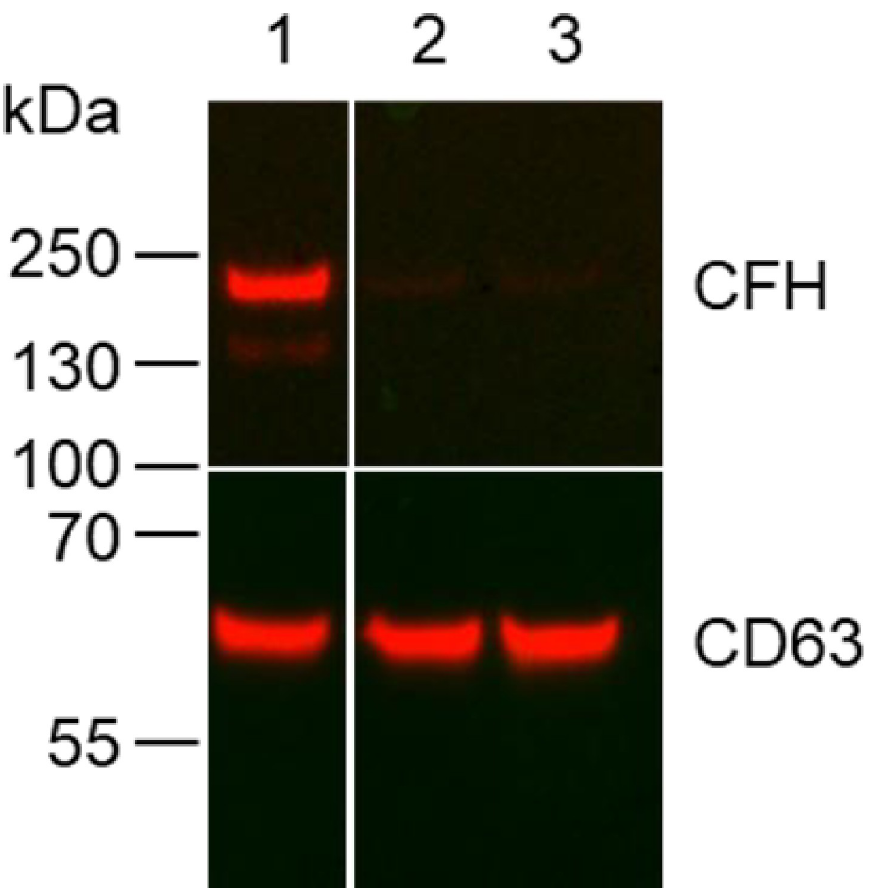
Fig 1. CFH in EVs from CMT167 wild type vs. CFH knockout lung cancer cell lines. EVs were isolated from cell line conditioned media and 7.5 μ g protein were western blotted and probed with GT103 and an anti-human IgG-HRP, then stripped and probed with anti-CD63 (SBI Biosystems) and a goat-anti-rabbit-HRP conjugate. A composite of the two images is shown. Lanes contain EV protein from 1, wild type CMT167; 2 and 3, two different CFH-CRISPR/Cas9 knockout cell